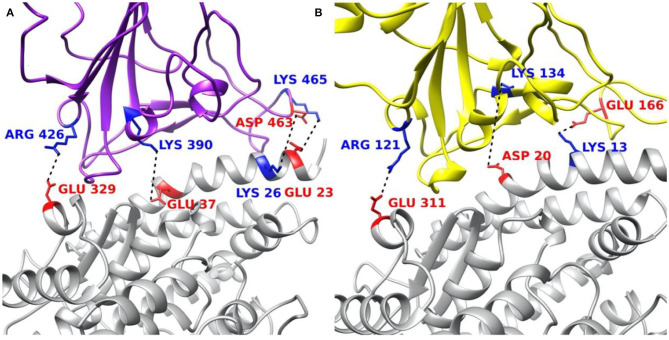
Structural demonstration of key residues that form salt bridges in the interface on both virus S protein RBDs and ACE2 RBD. (A) SARS-CoV S protein RBD (purple) and human ACE2 RBD (gray). (B) SARS-CoV-2 S protein RBD (yellow) and human ACE2 RBD (gray). Blue stands for positively charged key residues while red represents the negatively charged key residues.